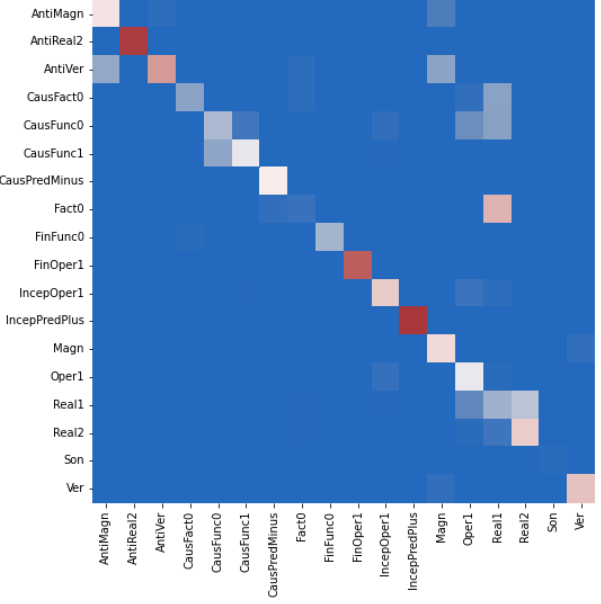
Figure 3. Confusion matrix for the classification of all LFs by our relation model on the English test set.